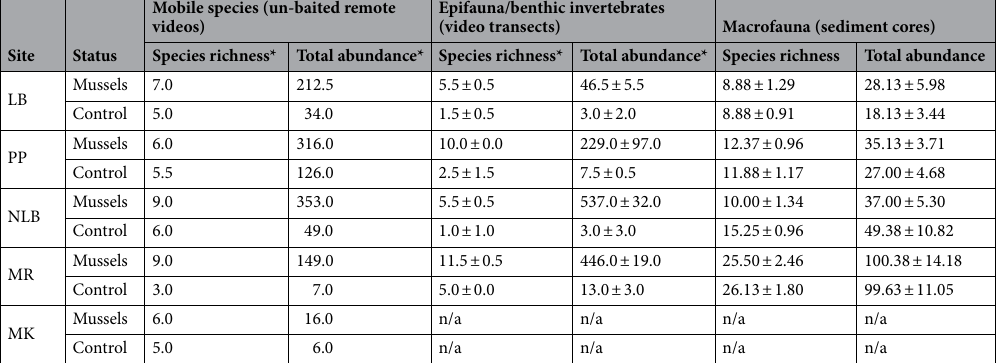
Table 3. Summary of univariate diversity indices for all three community data sets. Sites arranged over a decreasing mud gradient. Lagoon Bay = LB, Pukapuka = PP, New Lagoon Bay = NLB, Motuora = MR, and Motoketekete = MK. Asterisks (*) denote significant differences (2-way ANOVA, p < 0.05) between mussel beds and controls for the identified diversity index. Where applicable, data represent the mean ±